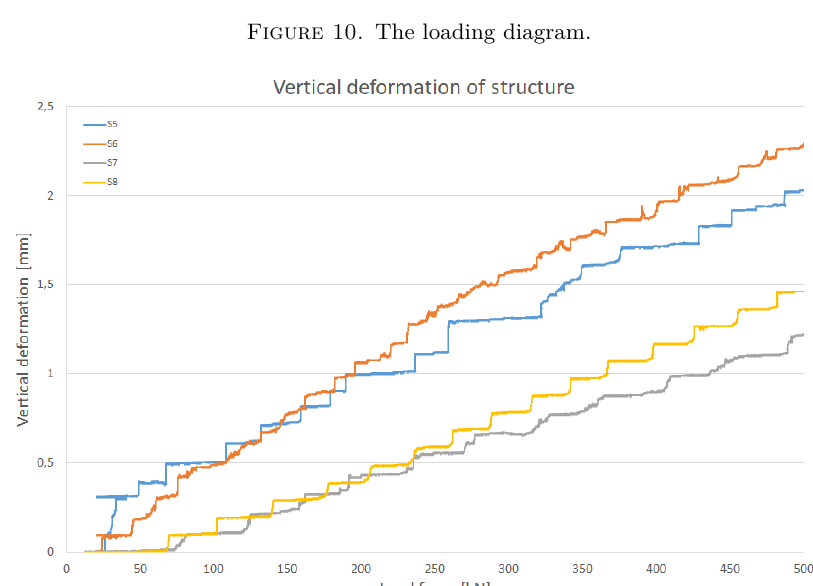
Figure 11. The vertical deformation.